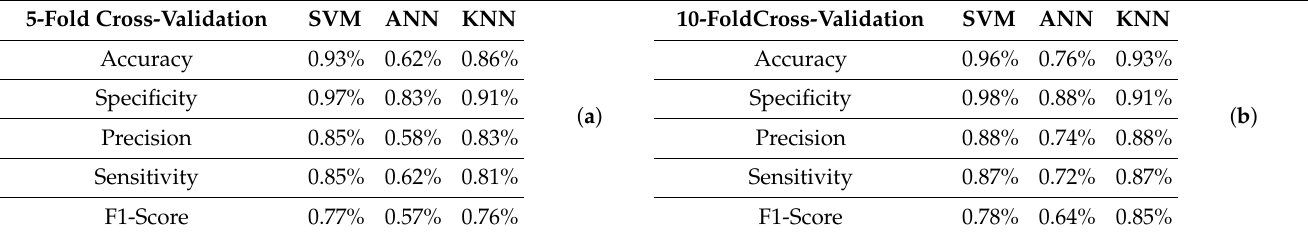
Table 1. Number of selected features .